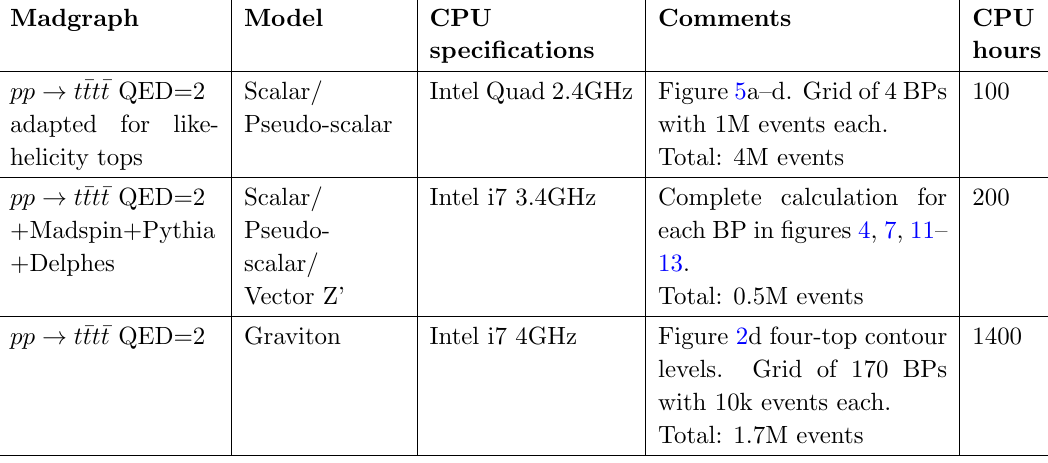
Figure 5a{d. Grid of 4 BPs with 1M events each.